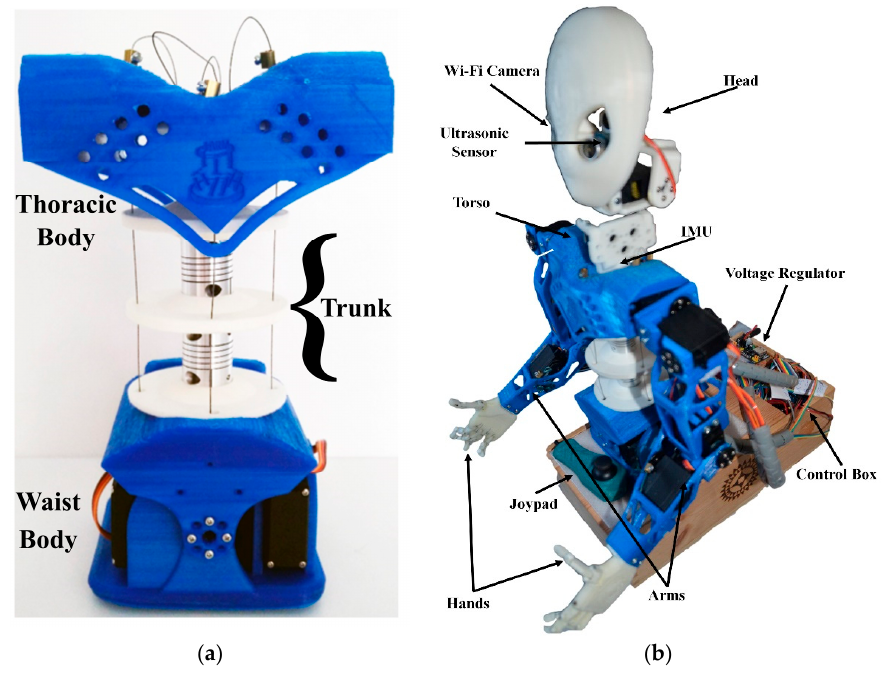
Figure 4. CAUTO prototype at LARM in Cassino: ( a ) the torso only, ( b ) the humanoid assembly.